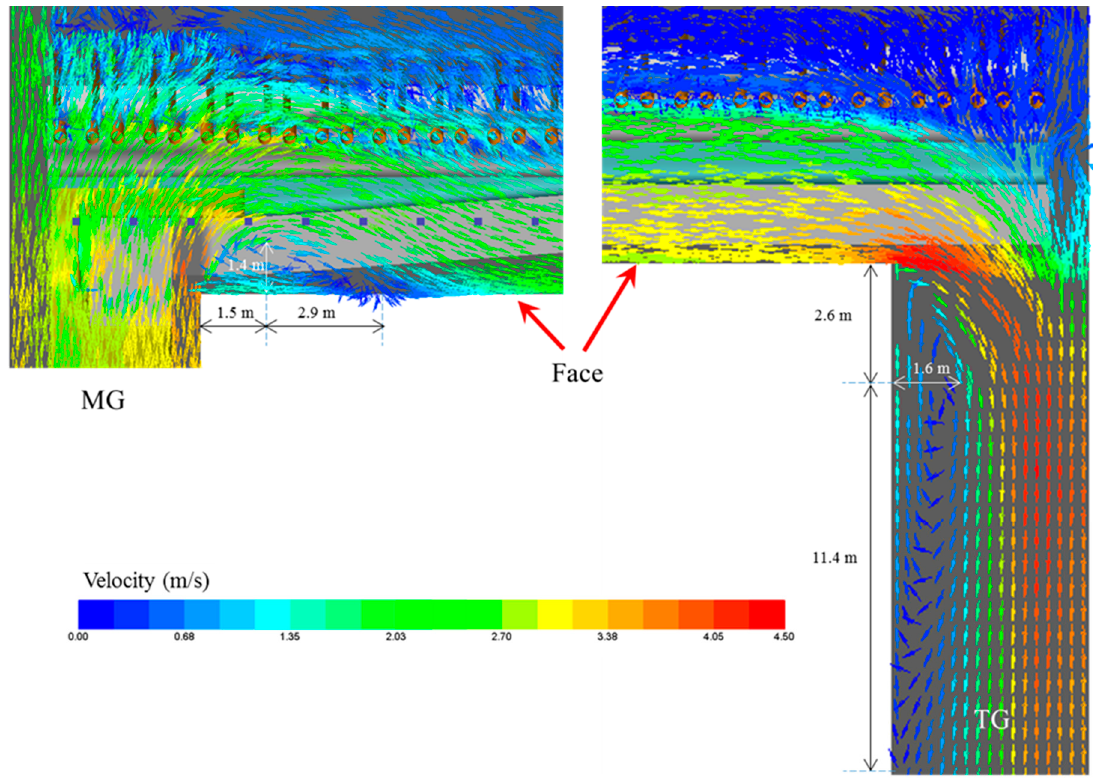
Figure 6. Flow patterns at the intersection of MG/TG and face indicating airflow separation.